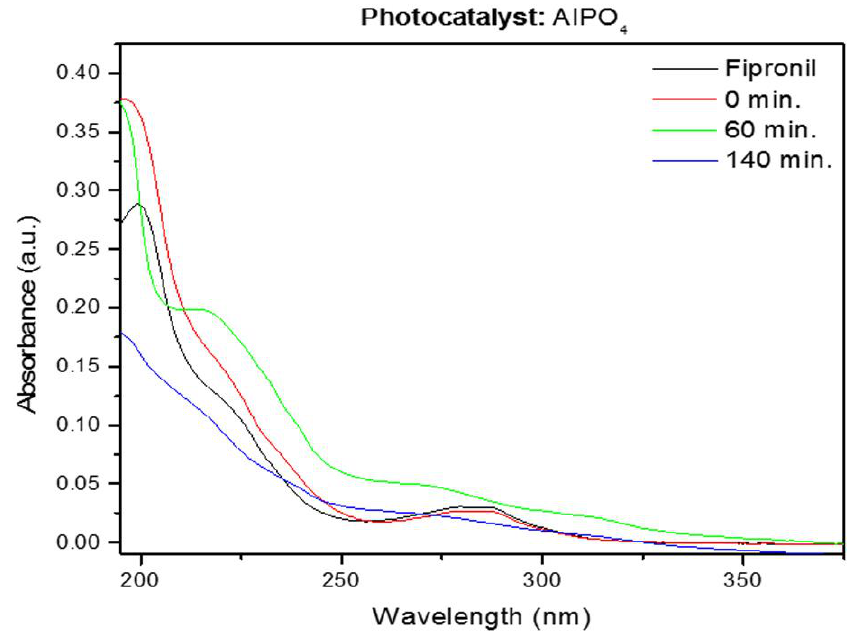
Figure 11. Fipronil (Ci = 2950 µ g L − 1 ) absorption spectra in the presence of 153 mg of AlPO 4 , under mechanical stirring and UV radiation (control reaction).